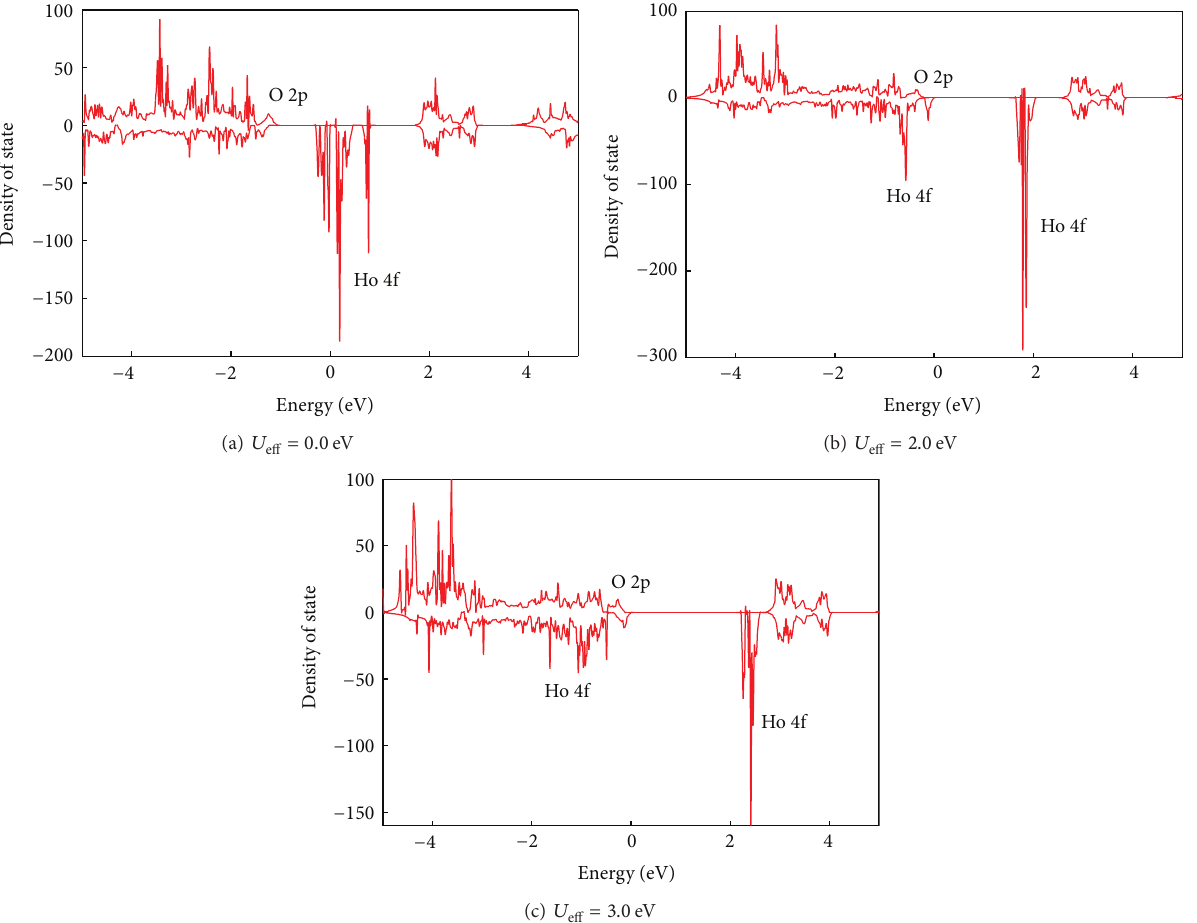
= 0.0 eV; (b) 𝑈 = 2.0 eV; and (c) 𝑈 = 3.0 eV. The upper and lower panels show eff eff eff